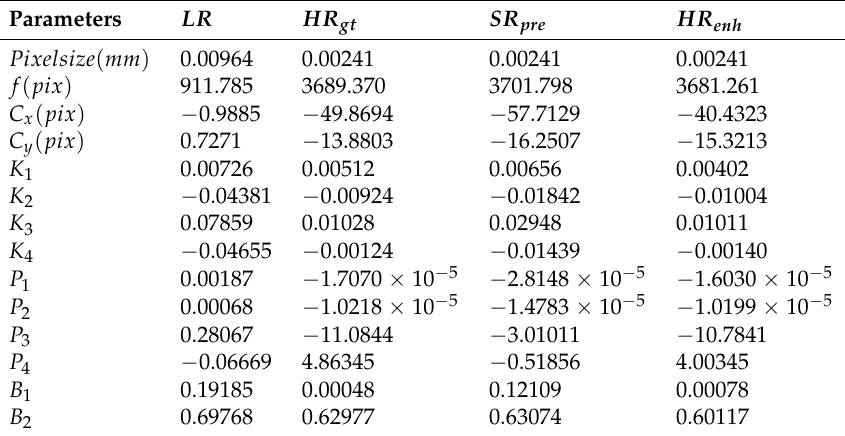
Table 3. Camera calibration